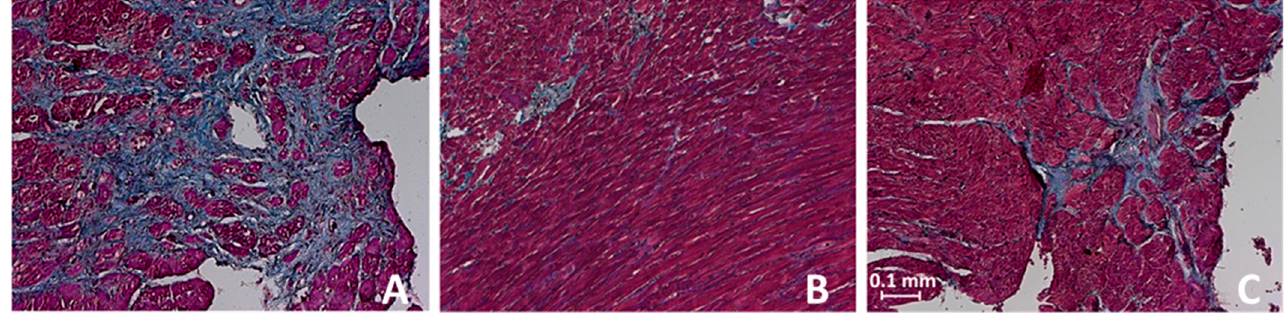
Figure 6. Hearts of 82-week-old CTRL and treated SHR in trichrome staining (10-fold magnification; the scale bar in part C represents 0.1 mm). ( A ): CTRL, perivascular and marked interstitial fibrosis, fibrosis degree of the group 2.3 ± 0.11; ( B ): CAP, perivascular and slight interstitial fibrosis, fibrosis degree of the group 1.8 ± 0.05; ( C ): CAP + NIF, perivascular and interstitial fibrosis, fibrosis degree of the group 2.1 ± 0.07 (data are given as means ± SEM).